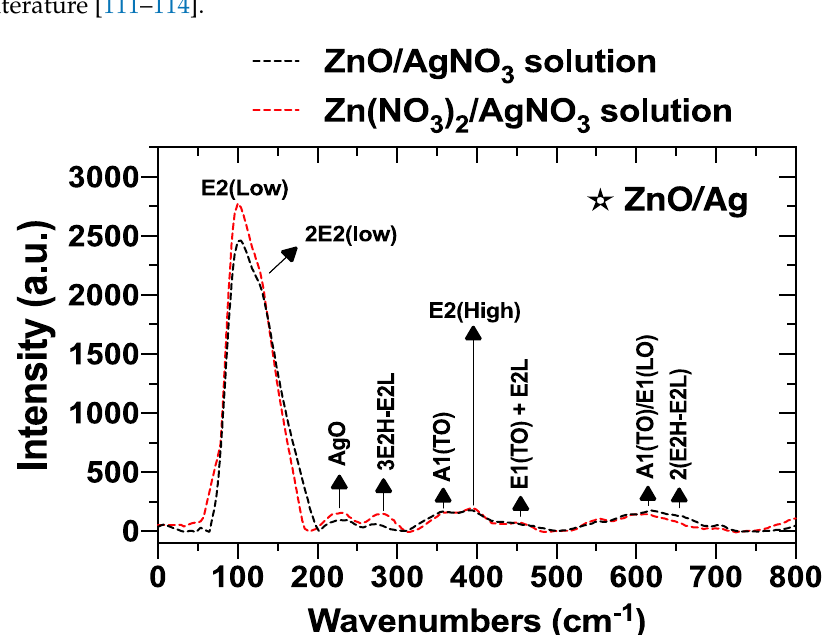
Figure 16. Raman spectra of hybrid ZnO/Ag-NPs deposits on the Mg-Ca0.3 surfaces, electroless achieved from (10 − 3 M, at 21 °C): ZnO/AgNO 3 and Zn(NO 3 ) 2 /AgNO 3 suspensions. achieved from (10 − 3 M, at 21 ◦ C): ZnO/AgNO 3 and Zn(NO 3 ) 2 /AgNO 3